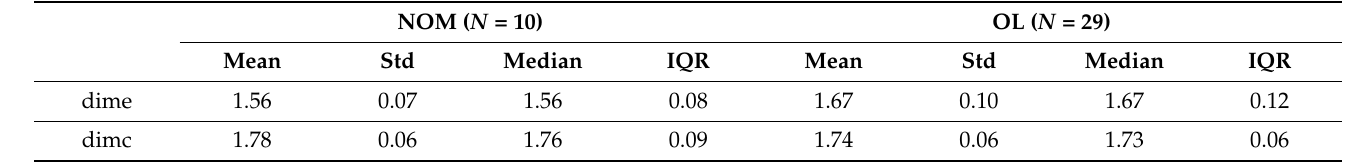
Table 2. Fractal dimension for dime and dimc in the OL and NOM